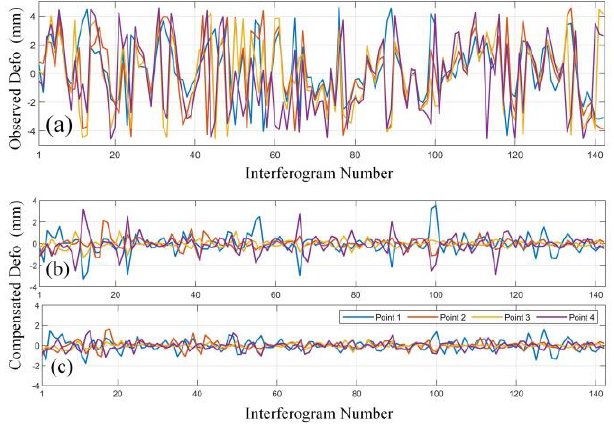
Figure 10. ( a ) The observed deformation in the interferograms for the four points of the Malan- zhuang area in Figure 9c. ( b ) the deformation compensated by the height-related model. ( c ) the deformation compensated by 3D model. compensated by 3D